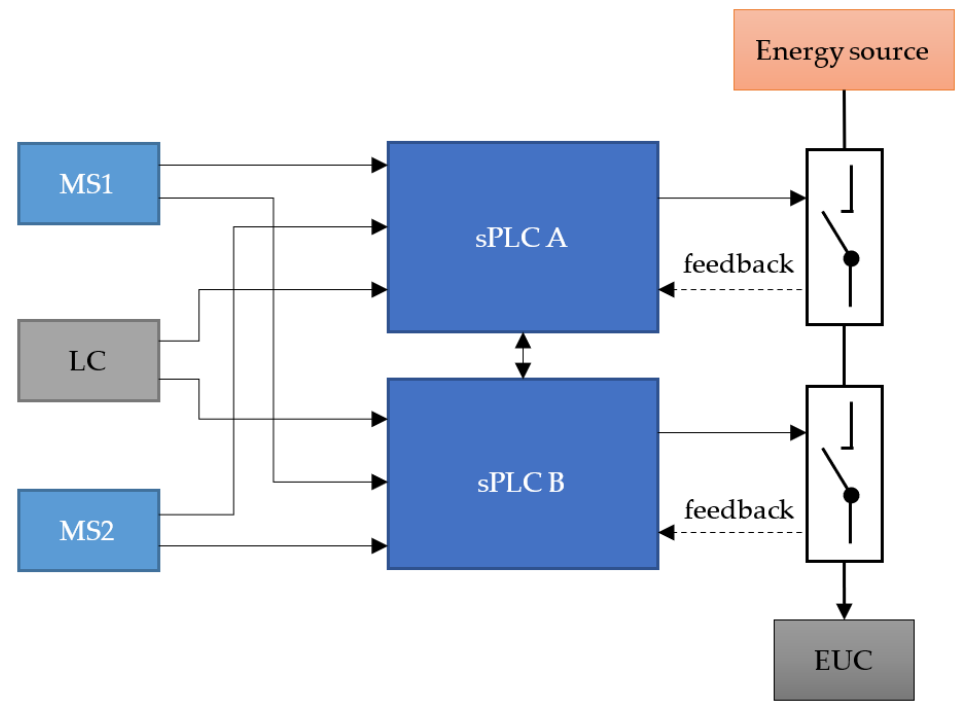
Figure 7. Block diagram of dual architecture based on sPLC.